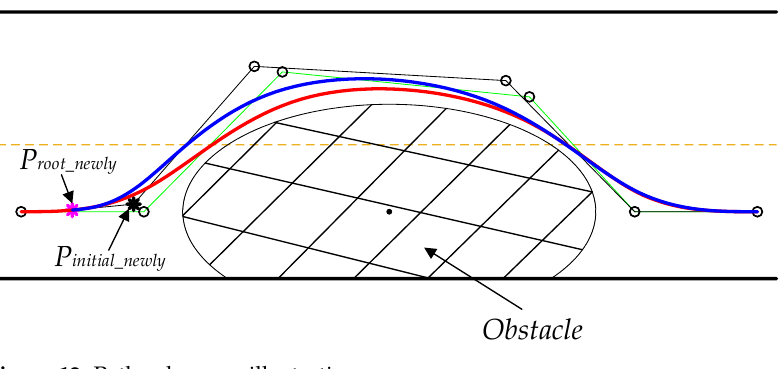
Figure 12. Path coherence illustration.